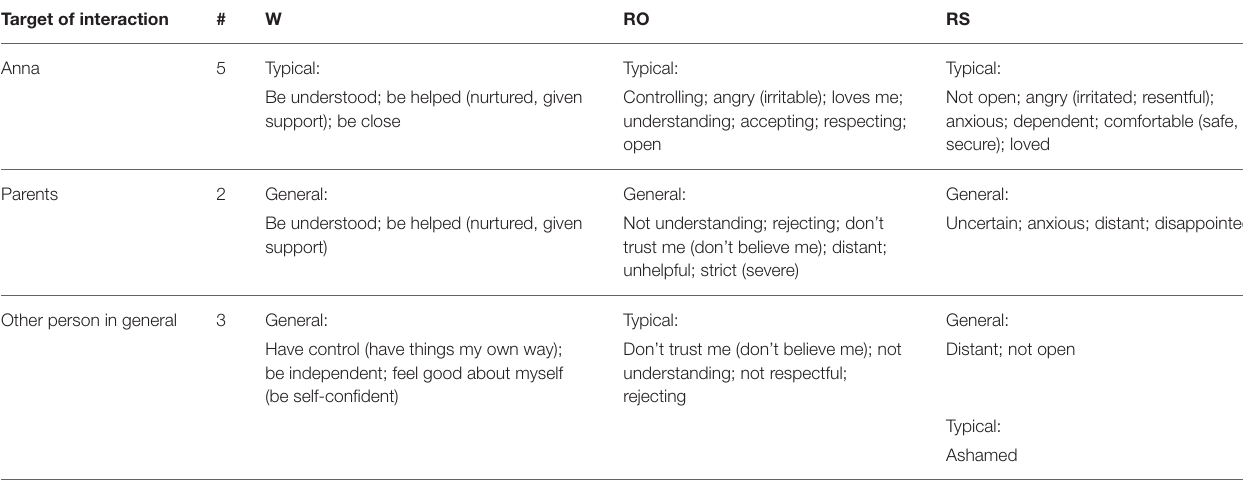
TABLE 3 | Patient’s wishes (W), responses of other (RO), and responses of self (RS) in sessions 14–17. Target of interaction